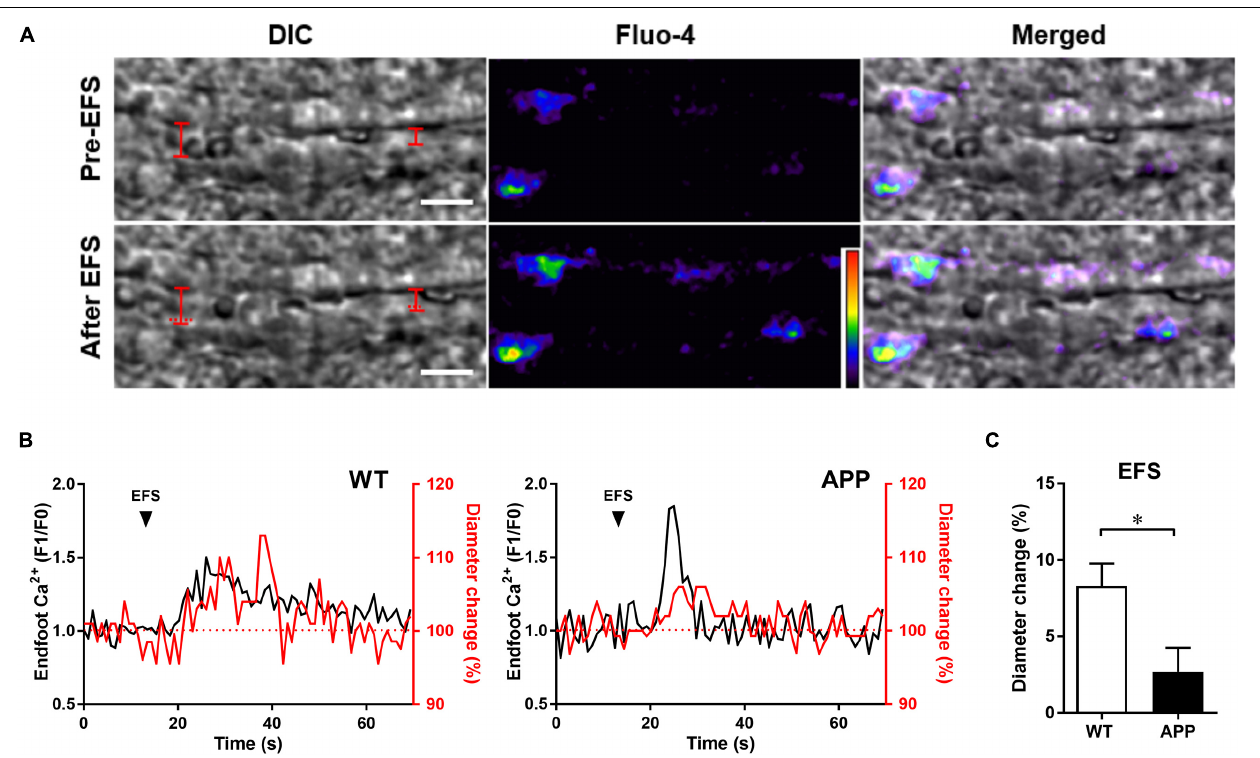
FIGURE 2 | Vascular and astrocytic Ca 2 + responses to electrical field stimulation (EFS) are impaired in hippocampal slices of APP mice. (A) Example of simultaneous recording of changes in arteriolar diameter and astrocytic endfoot Ca 2 + increases in response to EFS in an hippocampal slice from a WT mouse. Left panel: representing infrared differential interference contrast (IR-DIC) images of an hippocampal arteriole obtained Pre- and after EFS (scale bar, 10 µ m). The vascular diameter is labeled by red solid lines or dashed lines (indicate the pre-EFS position of the vessel wall). Middle panel: pseudocolor Fluo-4 AM fluorescence representing Ca 2 + in astrocytic endfeet surrounding an arteriole in an hippocampal slice. Right panel: Merged pictures from left and middle panels. (B) Representative traces of EFS induced changes in endfoot Ca 2 + (black) and arteriolar diameter (red) in WT and APP mice. (C) Hippocampal vascular dilation evoked by EFS in APP mice is reduced compared to WT controls ( ∗ p < 0.05; two-tailed unpaired t -test; n = 12–13). Analysis of Ca 2 + responses to EFS are presented in Figure 3 . F1/F0: fractional